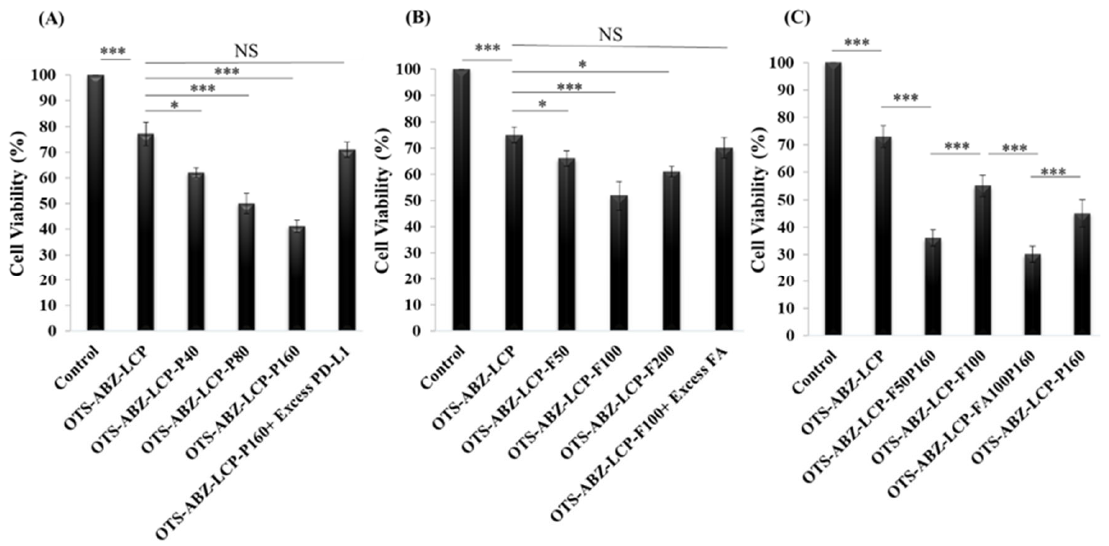
Figure 6. Enhanced cytotoxicity by bi ‐ anti ‐ PD ‐ L1 and/or FA conjugated LCP NPs. ( A ) Cytotoxicity of OTS ‐ ABZ ‐ LCP NPs, each conjugated with 40, 80 or 160 bi ‐ anti ‐ PD ‐ L1 antibodies; ( B ) cytotoxicity of OTS ‐ ABZ ‐ LCP NPs, each conjugated with 50, 100 or 200 folic acid ligands; and ( C ) cytotoxicity of OTS ‐ ABZ ‐ LCP NPs, each dually conjugated with different numbers of folic acid ligands and bi ‐ anti ‐ PD ‐ L1 antibodies. The doses of ABZ (100 ng/mL) and OTS964 (50 ng/mL) were selected based on their individual concentrations causing 80–90% reduction in cell viability (Figure 2). Data are presented as mean ± SEM (n = 3–5).